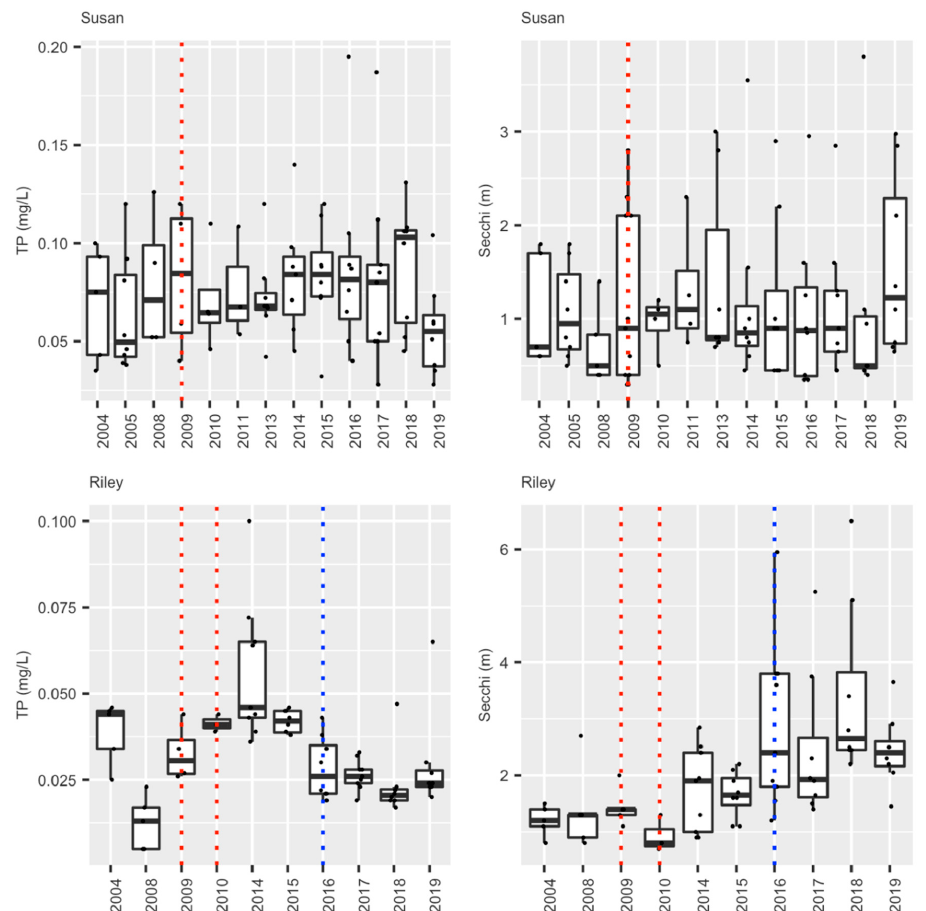
Figure 9. Summer (June–August) epilimnion water quality values (TP or Total Phosphorous, and Secchi depth (clarity)) for lakes Susan and Riley. The blue dotted line shows when the alum treatment occurred while the dotted red lines show years of carp removal in this system of lakes (see text).